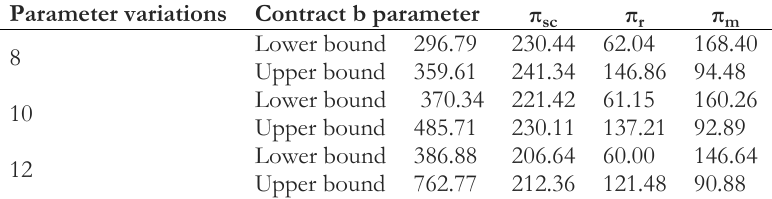
Table 9. Variations in firms' profits due to changes in maintenance costs